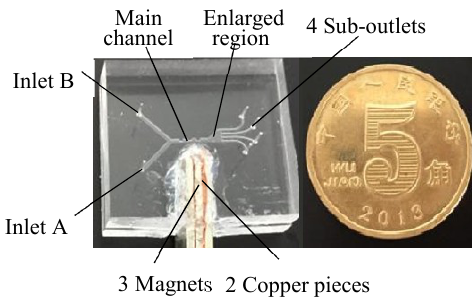
Figure 10. Sorter with the contraction–expansion channel for negative magnetophoresis.